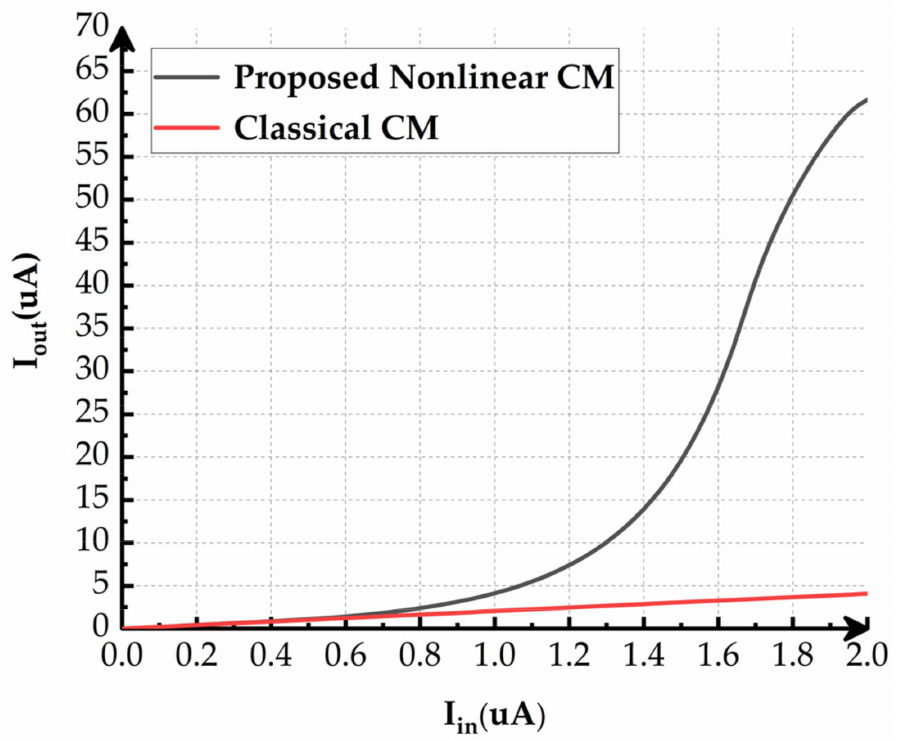
Figure 5. DC responses of the classical current mirror and the nonlinear current